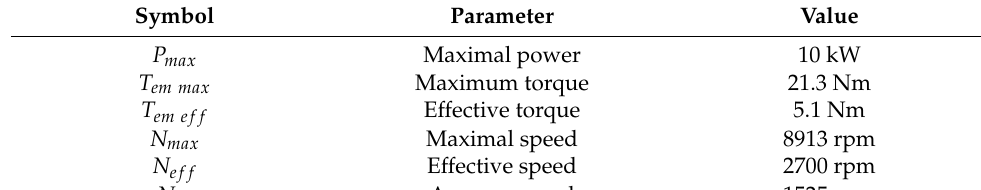
Figure 7. Pareto optimal front with temperature elevation in continuous ( a ) and intermittent ( b ) duties.